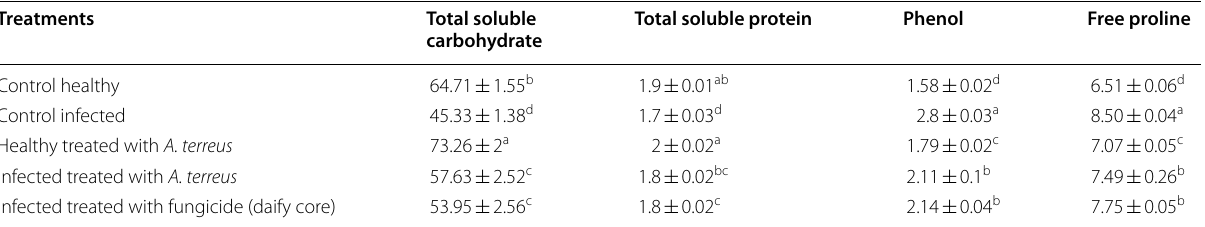
Table 2 Effect of A . terreus on carbohydrates, proteins, phenols and proline (mg g − 1 DW) of S. melongena . Each value represents mean standard ±